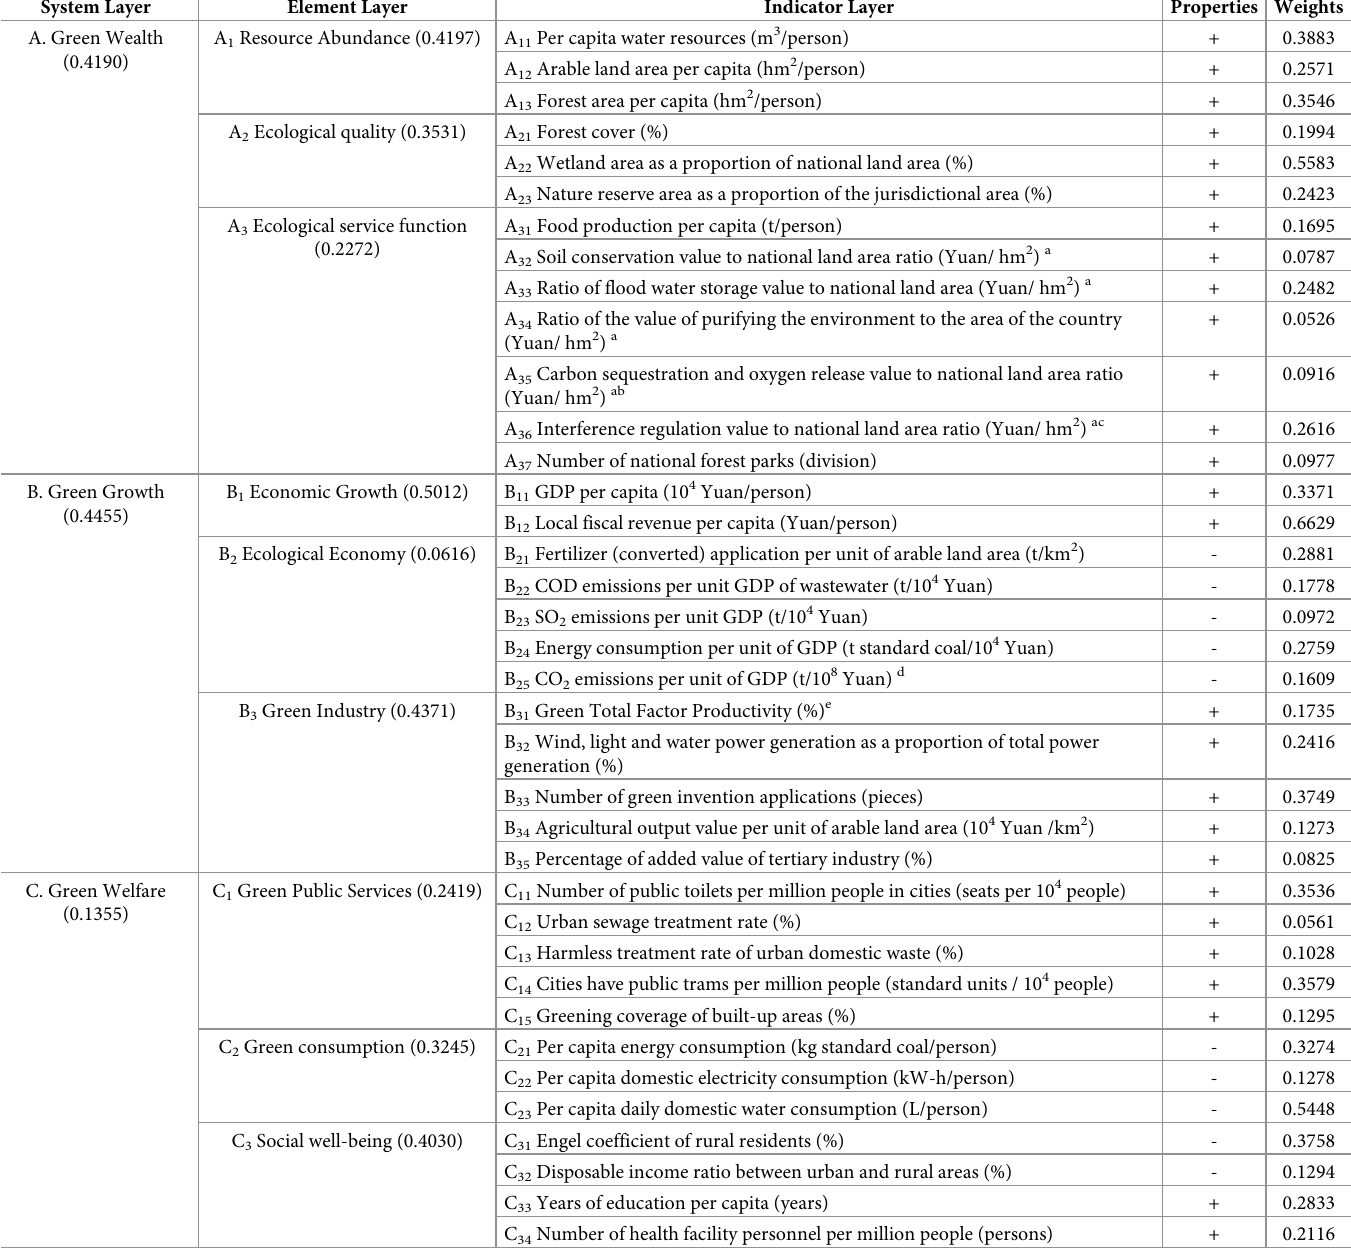
Table 1. Evaluation indicator system of China’s green development level in the context of carbon